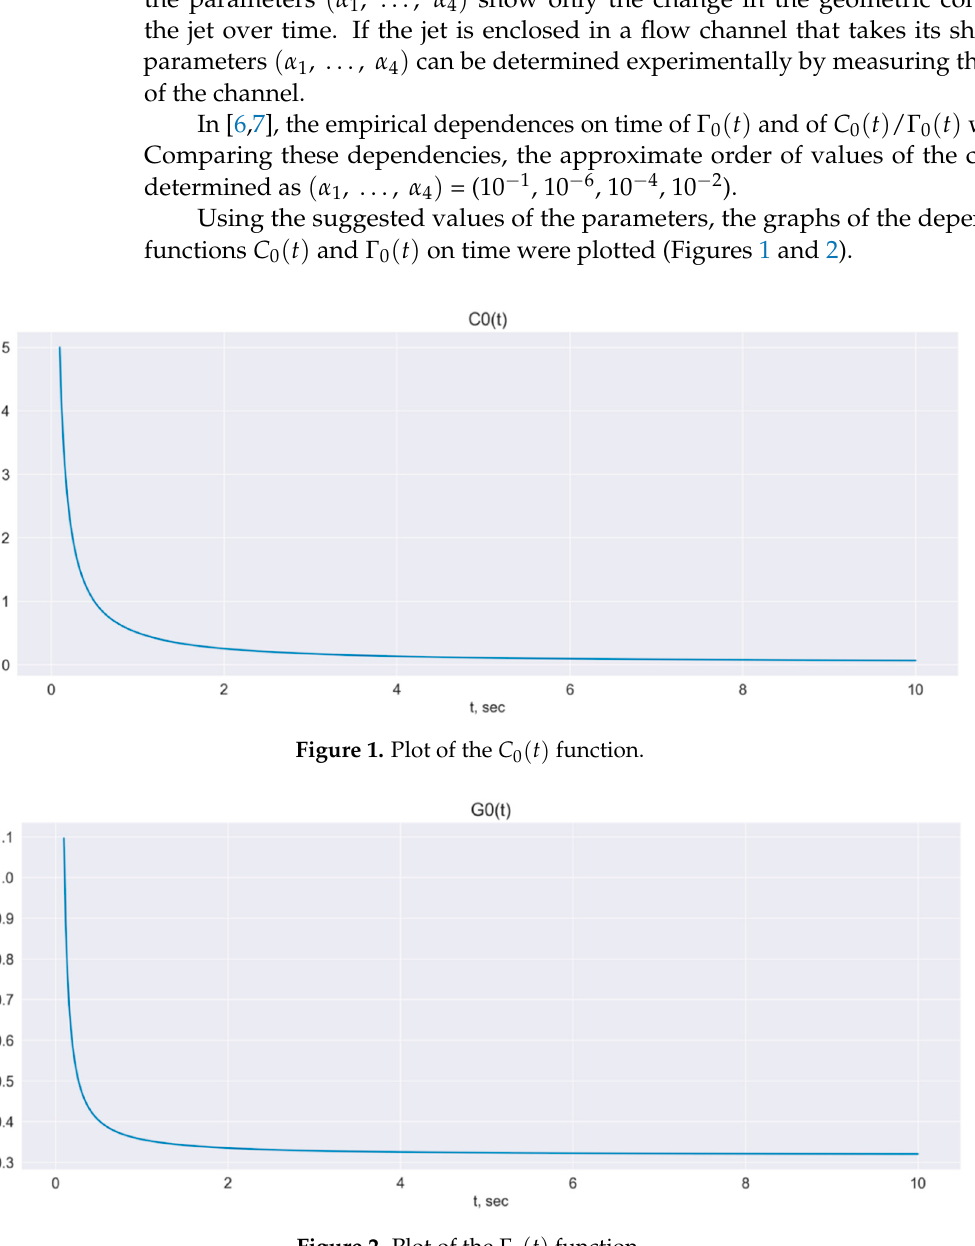
Figure 2. Plot of the Γ 0 ( t ) function.